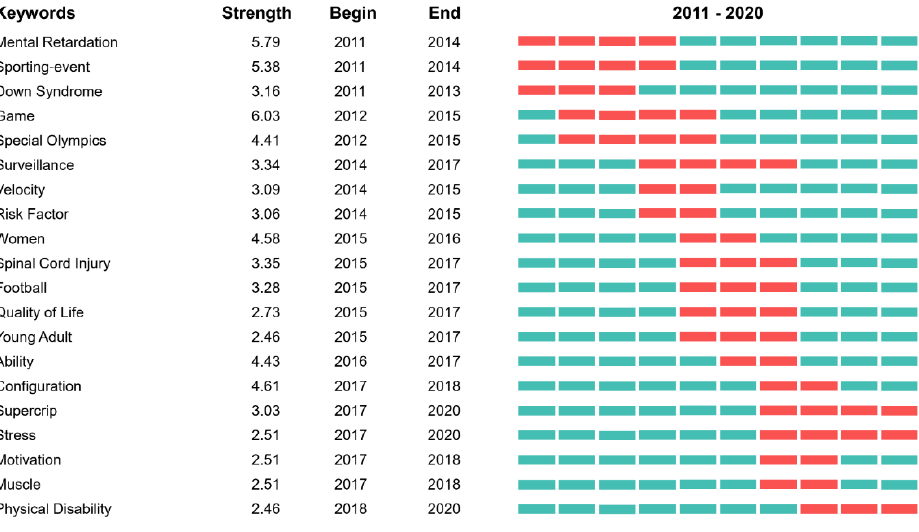
Figure 9. Keywords with the strongest citation bursts of publications on adapted sport.